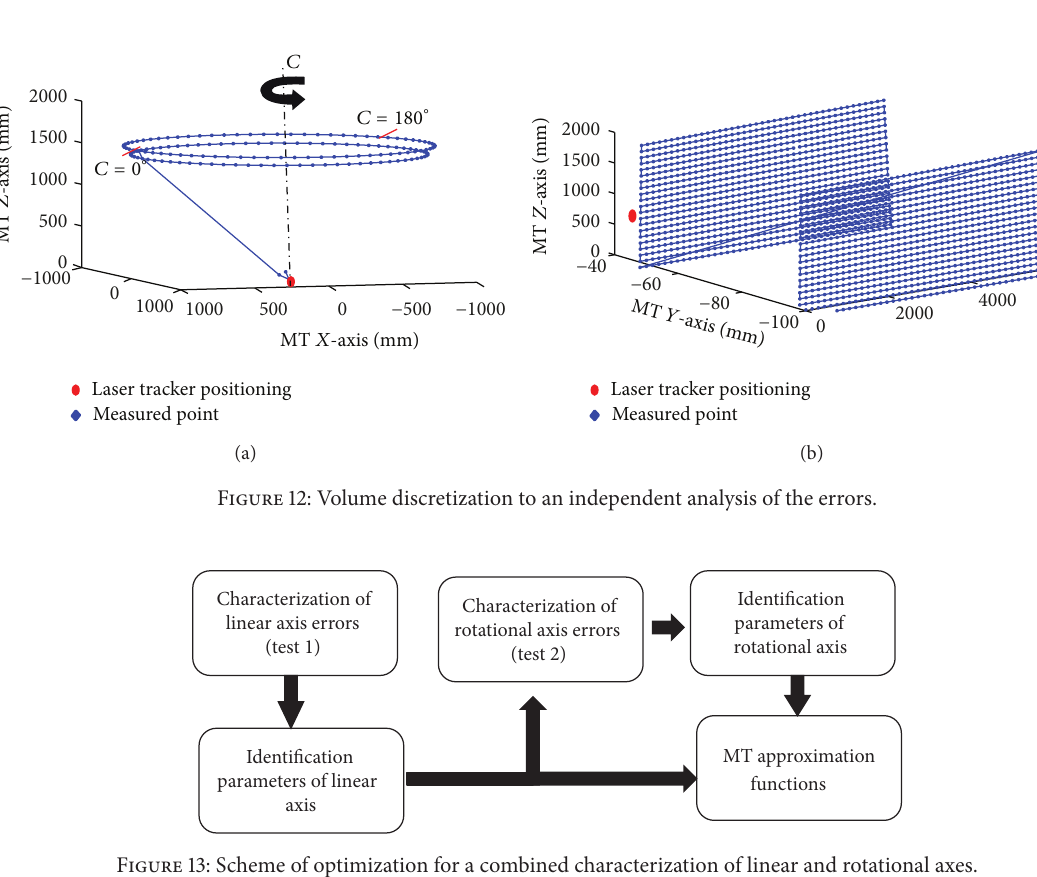
Figure 13: Scheme of optimization for a combined characterization of linear and rotational